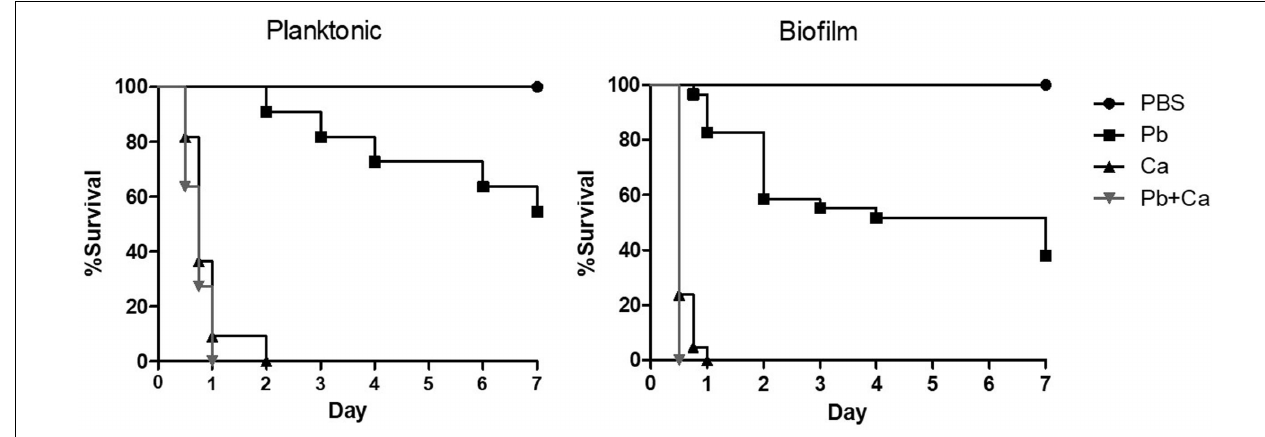
FIGURE 6 | Survival curve of Galleria mellonella larvae infected with 1 × 10 6 cells/larvae of planktonic cells, mono-, and dual-species biofilms grown after P. brasiliensis (Pb) was added to preformed C. albicans (Ca) biofilms. Larvae inoculated with PBS was used as control. The values are plotted as Kaplan–Meier survival curves and compared using log-rank